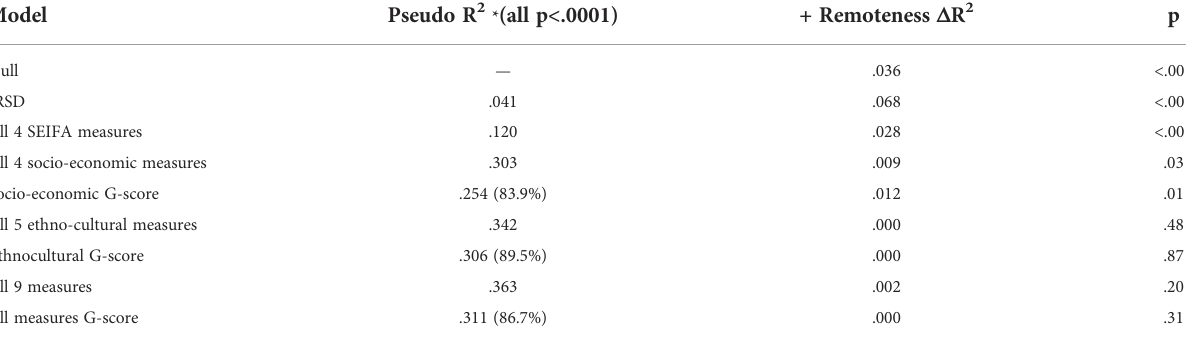
TABLE 3 Comparison of various spatial regression models of the relationship between socio-economic and ethnocultural characteristics of areas and breast screening participation. Model